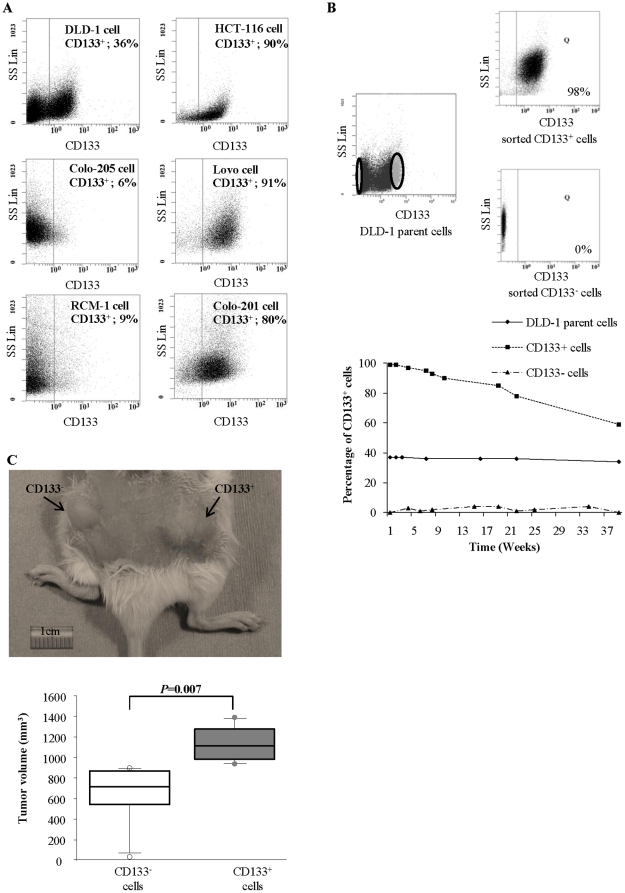
Biological behaviors of CD133+ colon cancer cells in vitro and in vivo.(A) CD133+ populations in a panel of human colon cancer cell lines. Flow cytometry analyses were performed to investigate the CD133+ populations in 6 colon cancer cell lines. (B) Analysis of the CD133+ population in parental DLD-1 cells and reanalyses of sorted CD133+ cells (98%) and CD133− cells (100%) (upper panels). The time-dependent changes in the CD133+ populations in unsorted parental and sorted CD133+ and CD133− DLD-1 cells are also shown (lower panel). The sorted CD133+ cells show significant time-dependent changes in the CD133+ and CD133− populations during long-time culture, while the percentages of the CD133+ and CD133− populations do not change in the parental cells and sorted CD133− cells. (C) Tumor growth was evaluated at 1 month after injection of 5×106 CD133+ or CD133− DLD-1 cells into 6 SCID mice, respectively. Representative photographs are shown in the upper panel (left: CD133− cell-derived tumor; right: CD133+ cell-derived tumor). Scale bar = 1 cm. The CD133+ cell-derived tumors are significantly larger than the CD133− cell-derived tumors (P = 0.007; lower panel). Data represent means ± SD.